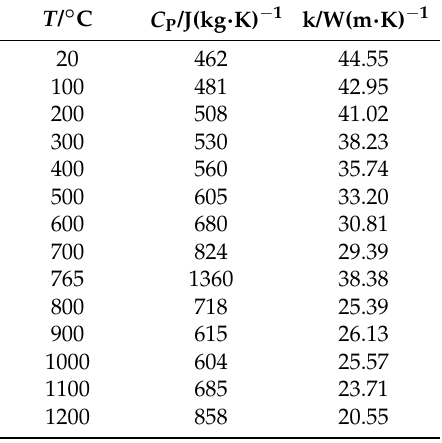
Table A1. Thermophysical